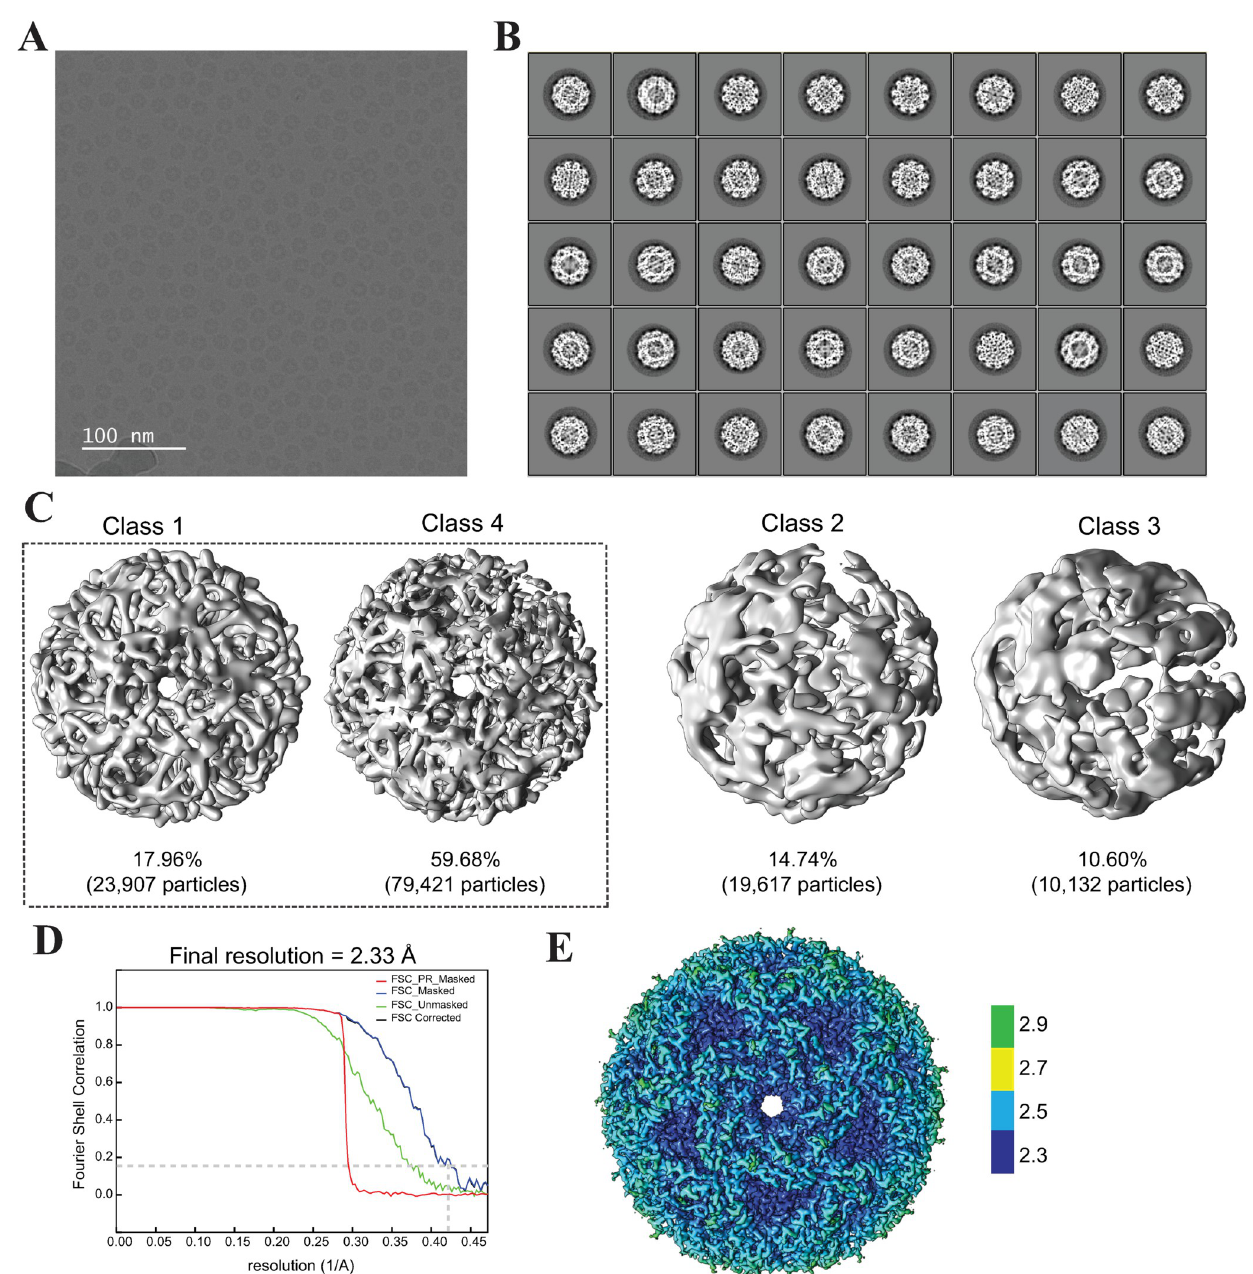
Fig 4. Cryo-EM imaging and 3D reconstruction of Lumazine Synthase (LS) cryo-EM map. ( A ) Representative micrograph of LS enzyme acquired in super-resolution mode and at 130 kx magnification. The scale bar represents 100 nm. ( B ) The 2D classes selected for 3D classification contained 133,077 particles distributed at random orientations. ( C ) The selected 2D classes were 3D classified into four classes. Classes 1 and 4 represented 77.64% of the total number of particles and showed the characteristic channel parallel to the 5-fold pentamer axis. The particles from both classes 1 and 4 were used for subsequent refinement. ( D ) The FSC plot shows the resolution of unmasked and masked maps after post-processing in RELION. The final resolution of the cryo-EM map is 2.33 Å at FSC = 0.143. ( E ) The cryo-EM map is color-coded with the local resolution estimate obtained from RELION. The data processing pipeline flowchart for LS is depicted in S4 Fig